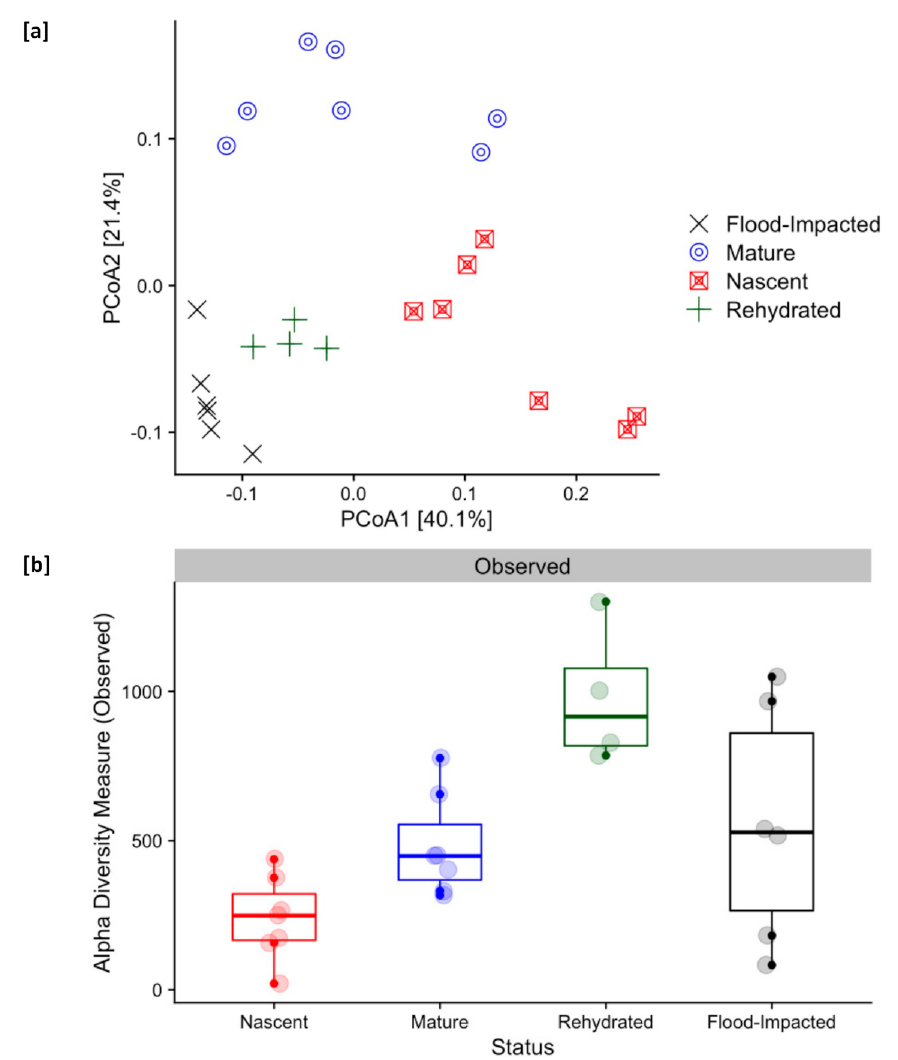
Figure 5. Comparison of microbial ecological signatures between nascent, mature, rehydrated, and flood-impacted samples demonstrates a significant change within the microbial community as a result of each disruption. A biomat is considered nascent prior to completing one full growing season and mature after that. As can be seen from the Weighted UniFrac PCoA ( a ), the flood-impacted biomat and rehydrated biomat communities were significantly different from both mature and nascent biomats (SI Table S2). ( b ) The range of observed amplicon sequence variants (ASVs.) in the flood-impacted samples demonstrates the microbial community likely underwent random selection due to the samples being taken after the inflow to the wetlands was shut off. Coupled with the significant shift between rehydrated and mature biomats (Mann–Whitney U test, p < 0.05), this suggests both disruptions had an impact on the microbial assemblage of the